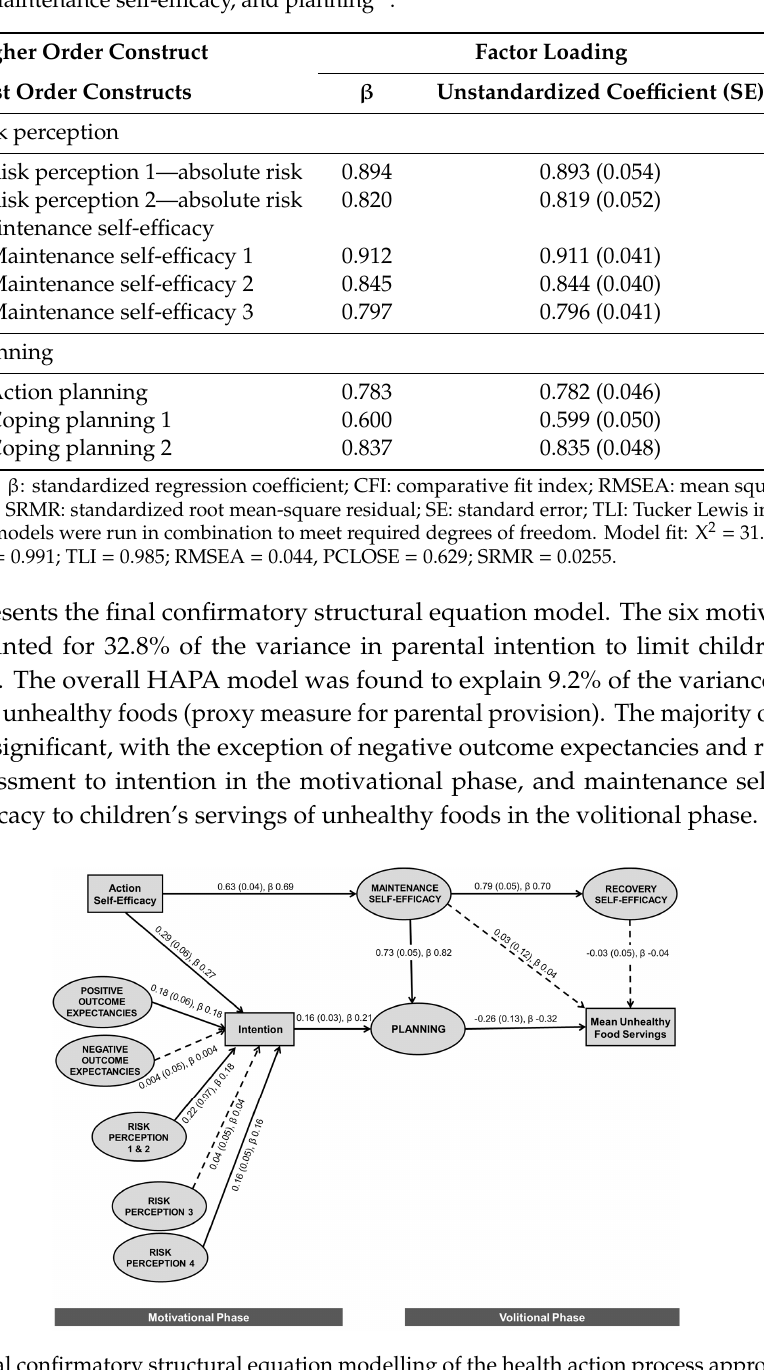
Table 4. Second order confirmatory factor analysis regression weights for latent constructs of risk perception, maintenance self-e ffi cacy, and planning 1 .